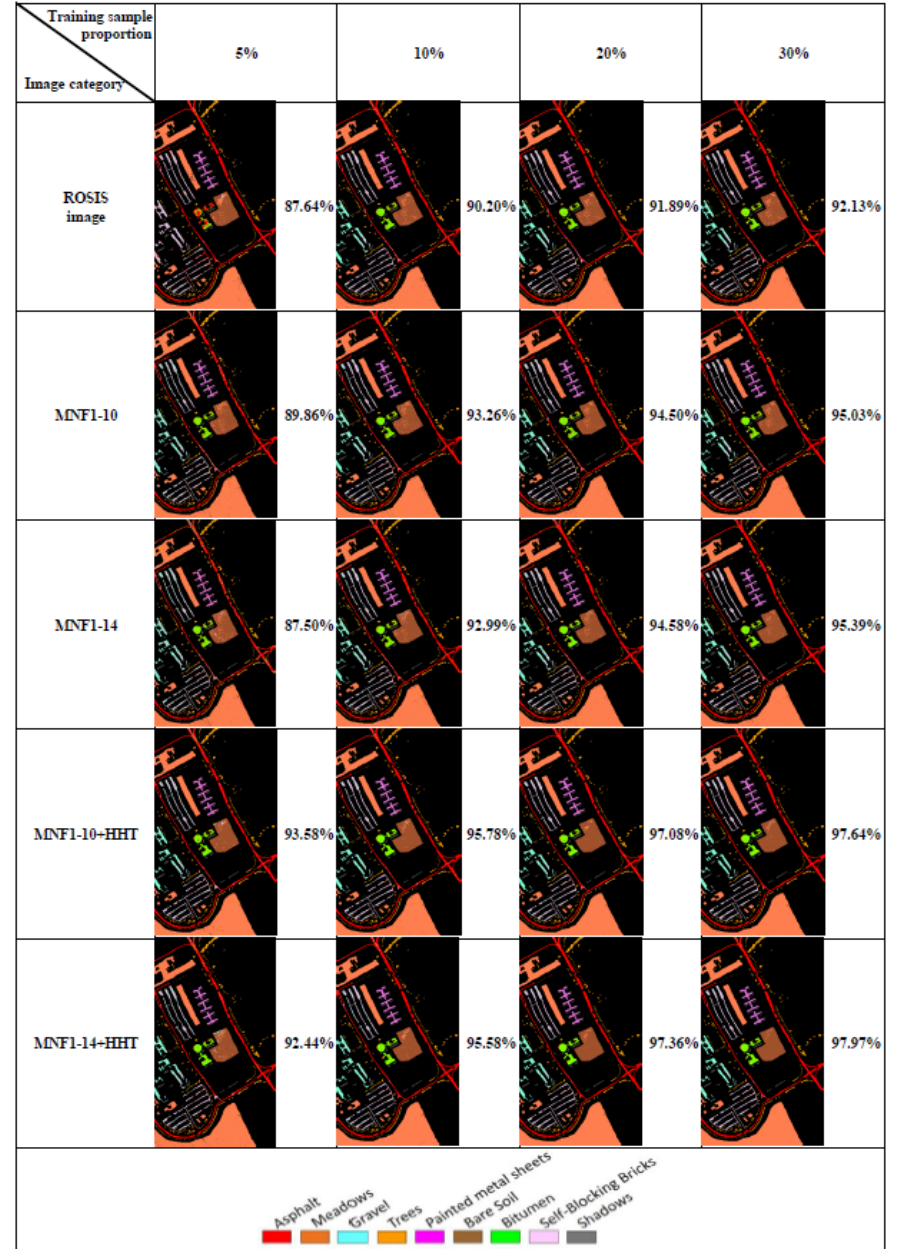
Figure 5. Classification results with overall accuracy values for PaviaU dataset original 103 band images, MNF-transformed images, and MNF+HHT-transformed images with four training sample proportions.